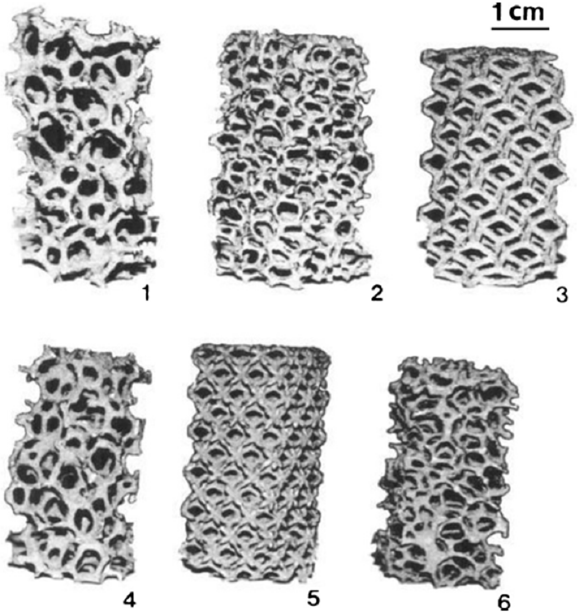
Figure 8. Examples of open cellular Cu mesh and foam specimens Stochastic foams are shown in ( 1 ), ( 2 ), ( 4 ) and ( 6 ): reticulated mesh samples are shown in ( 3 ) and ( 5 ). Reproduced with permission from [105] Elsevier, 2011.